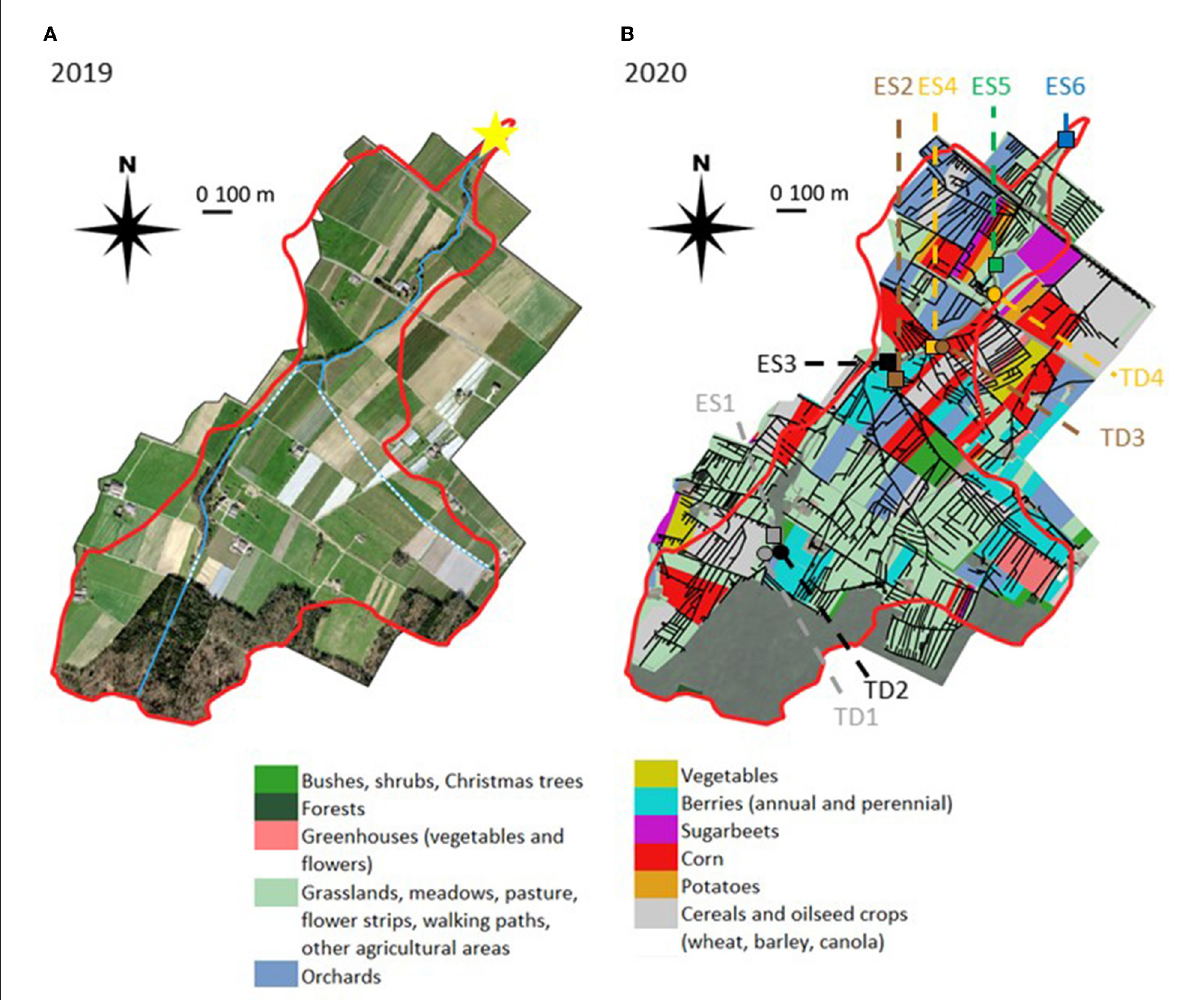
FIGURE1 Visualization of the heavily-drained agricultural catchment located in the north-east of Switzerland studied in this research. (A) Aerial photo at 10cm pixel resolution showing the presence of the riparian vegetation all along the open stream and of few greenhouses. Photo taken on March 29 th 2019 available from the Swiss Federal Office of Topography. The red line depicted the topographical catchment. Stream as open flow covered by riparian vegetation in blue line and as culvert in dashed white-blue line. Sampling location at the catchment outlet as yellow star. (B) Landuse at parcel level in 2020 as color filled areas specified in the legend available from the Cantonal Office of “Inneres und Volkswirtschaft.” Dense drainage network as black line. Filled squares indicate the locations of surface water grab samples (label starting with “ES”), while filled circles represent the sampled tile drain outlets (label starting with “TD”). Background to depict non-agricultural lands (i.e., forests, riparian trees, and urban areas) was the true color image from Sentinel-2 at 10m pixel resolution sensed on August 12 th ,